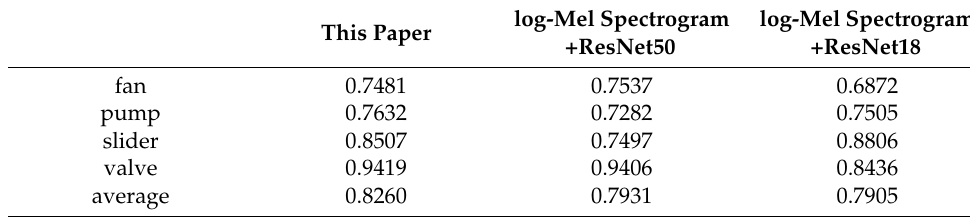
Figure 7. Construction of the training process dataset using the outlier exposure method. Table 4. Performance of different monitoring models.